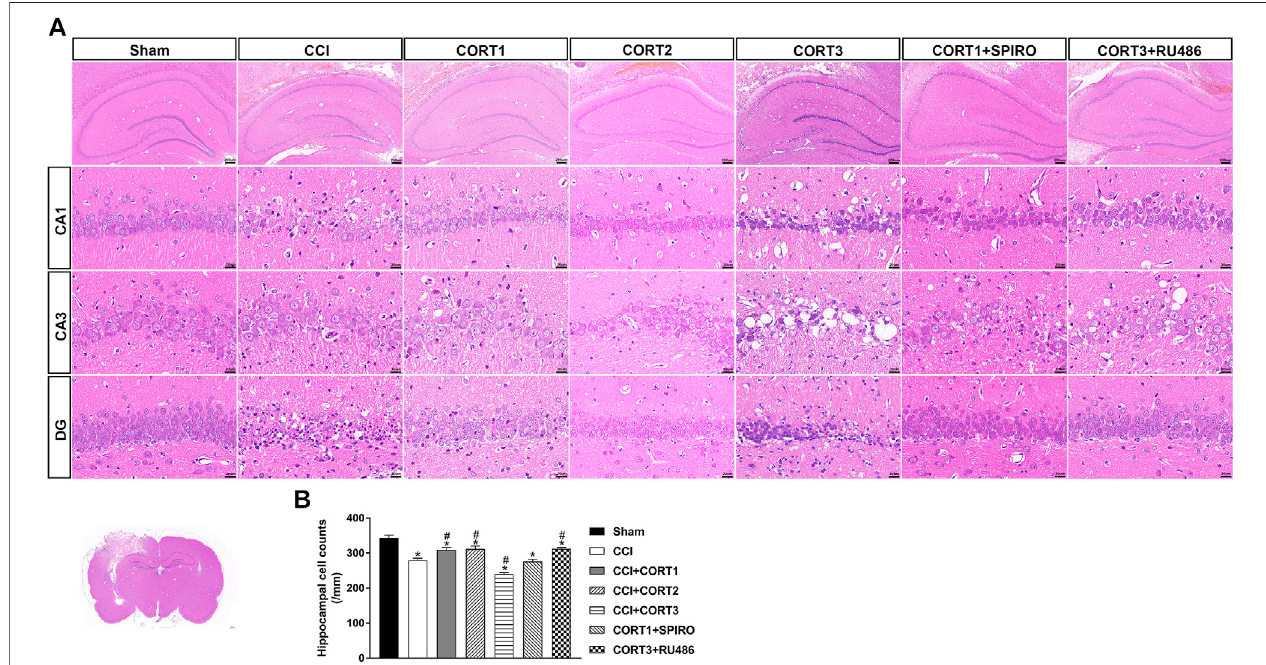
FIGURE 4 | Dose-dependent effects of CORT treatments on neural cell in the ipsilateral hippocampus after CCI. (A) Representative images of H and E staining samplesshowingneuralcellsinipsilateralhippocampalsubareas. (B) Quanti fi cationofcellsintheipsilateralhippocampus.* p < 0.05versustheshamcontrolgroup; # p < 0.05 versus the CCI control group. The data are presented as the means ± SDs. Scale bar (cid:1) 200 μ M for the upper row of Panel 4A and 20 μ M for CA1, CA3, and DG rows of Panel 4A.